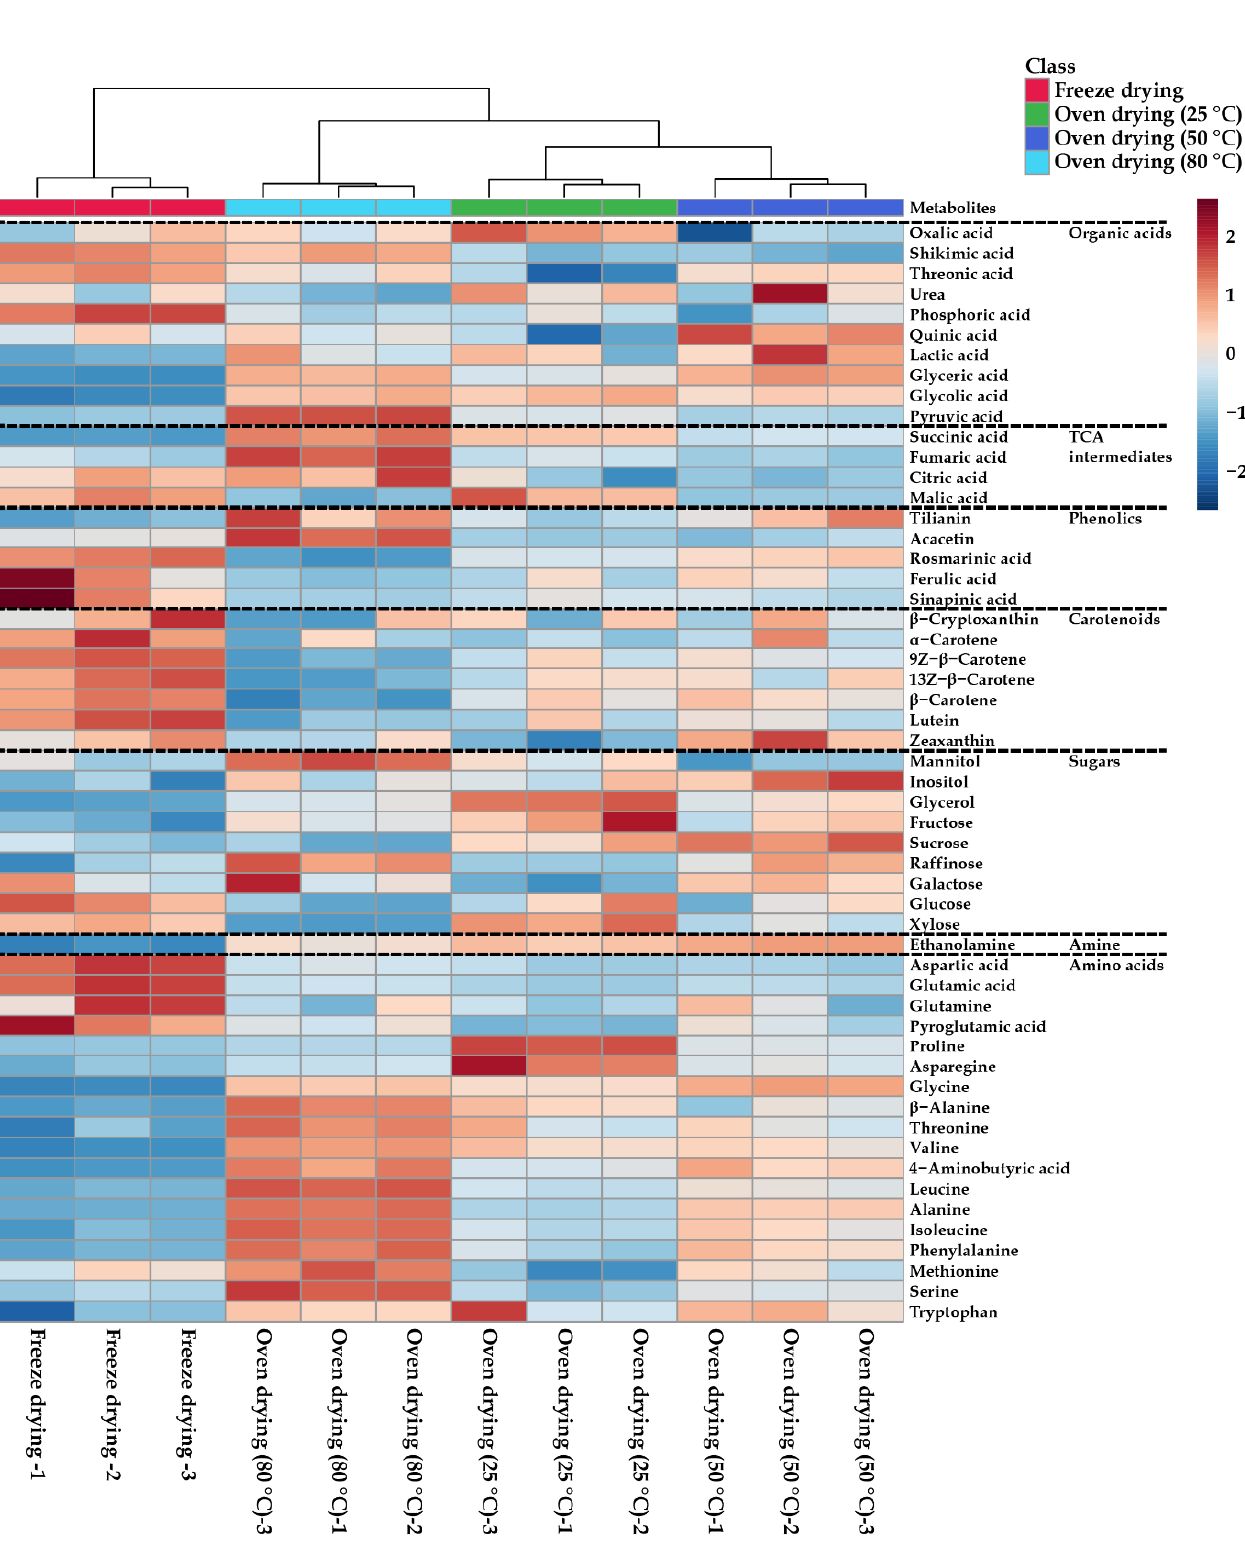
Figure 1. Heatmap represents the differences in A . rugosa flowers dried using freeze dryer and oven dryer at 25 °C, 50 °C, and 80 °C. Increasing and decreasing the contents of metabolites are shown by red and blue color, respectively.